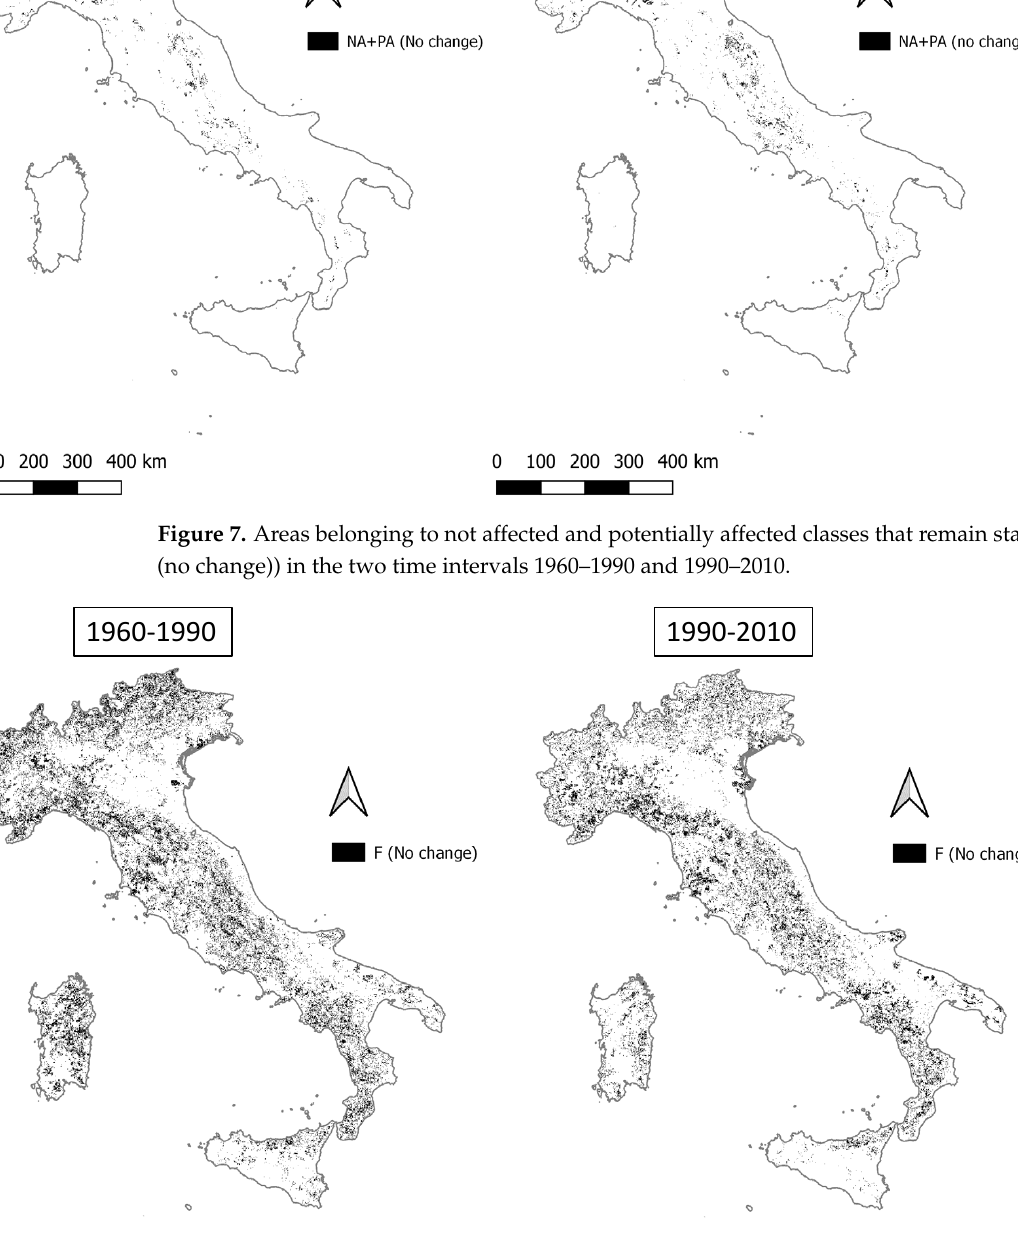
Figure 8. Fragile areas remaining stable (F (no change)) in the two time intervals (1960–1990 and 1990–2010). The percentage of land stably classified as ‘critical’ (C) increases from 12.4% (1960– 1990) to 17.2% (1990–2010). In both periods, areas classified in this macro-group are distributed mostly along coastal and flat areas (Figure 9).